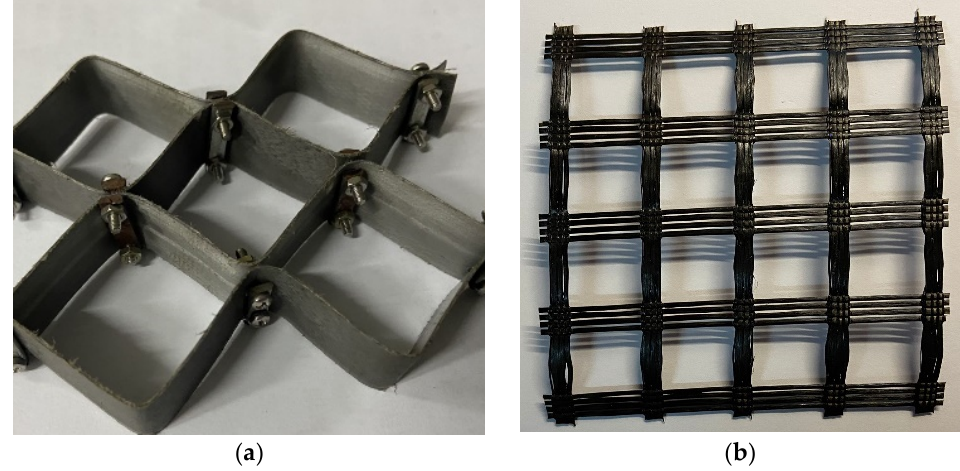
Figure 1. Reinforcing materials: ( a ) the PP geocell; ( b ) the GF geogrid. Table 3. Performance of PP geocell and GF geogrid.